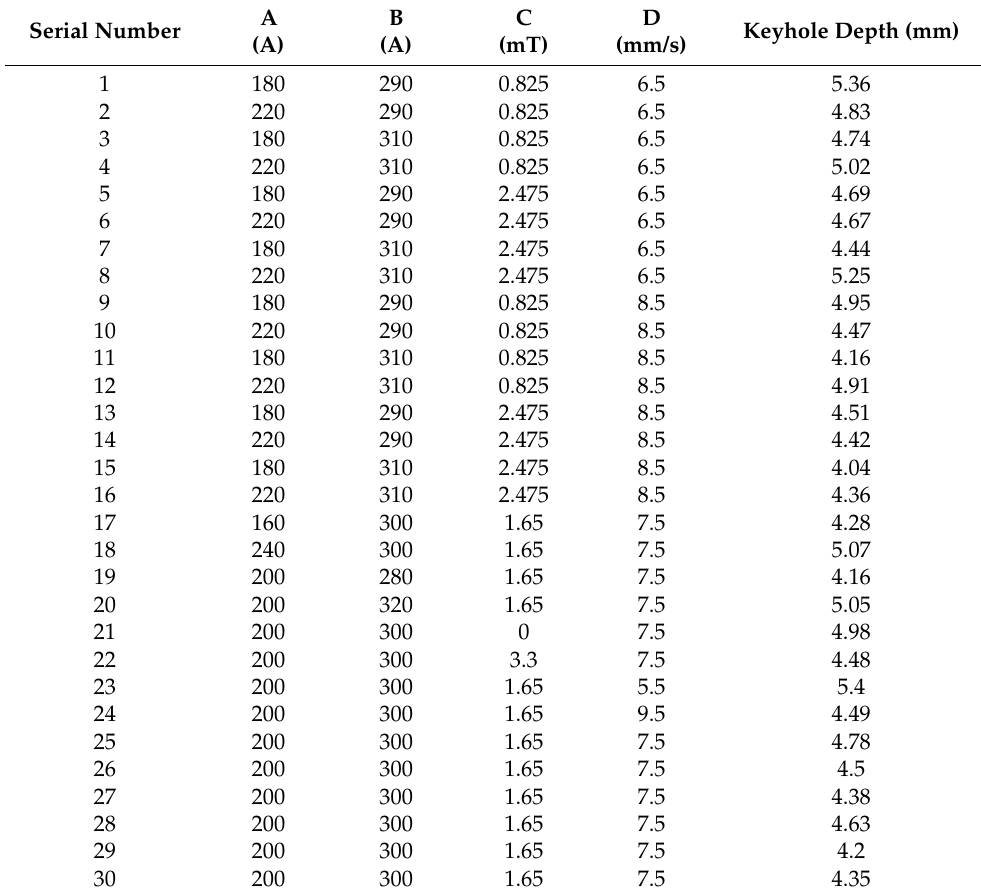
Table 4. CCD design and test